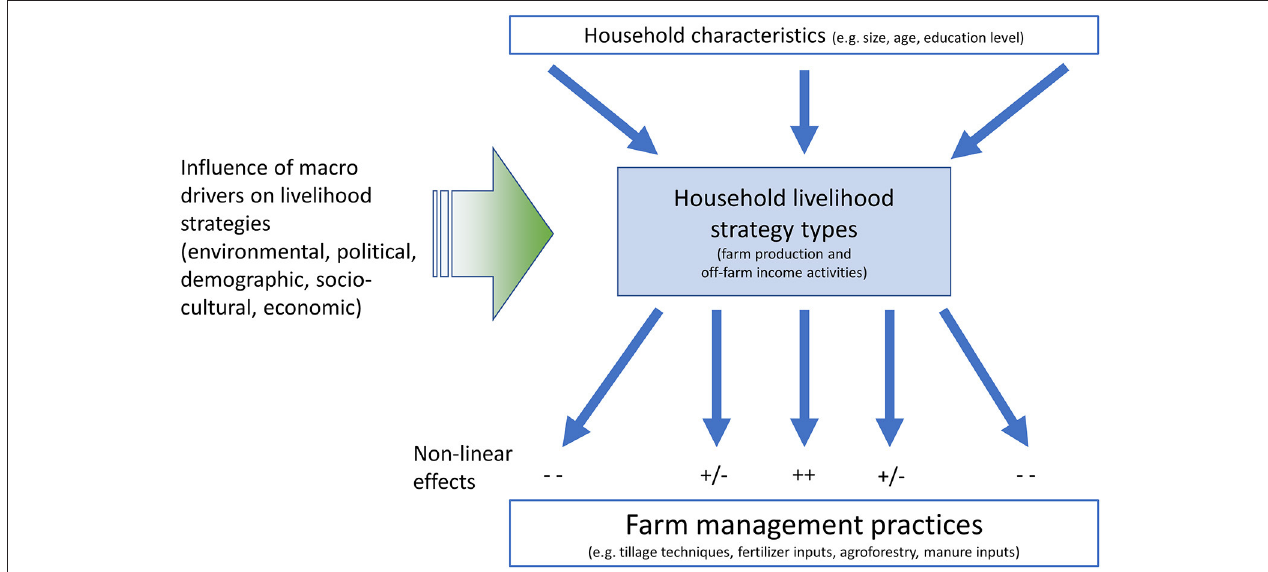
FIGURE 1 | Conceptual model outlining the relationships between rural household characteristics, livelihood strategy diversification, and farm management.